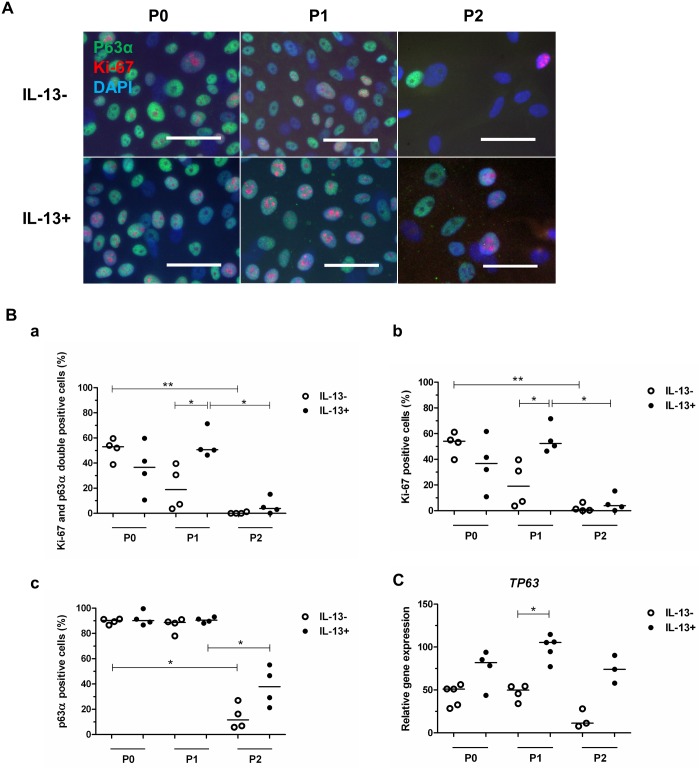
Immunofluorescent Ki-67 and p63α double staining and the relative TP63 gene expression in IL-13- or IL-13+ cell cultures.(A) At the end of cultivation, P0 cells originating from limbal explants and P1 and P2 cells were analyzed by immunofluorescent staining for Ki-67 (red) and p63α (green); nuclei were counterstained with DAPI (blue). Scale bars: 50 μm. (B) Distribution of percentages in P0, P1, and P2 groups for Ki-67 and p63α double staining (a), and Ki-67 (b) and p63α (c) immunostaining. (C) qPCR analysis of relative TP63 gene expression. All data are presented in vertical scatter plot graphs with line indicating median. *P < 0.05, **P ≤ 0.01.